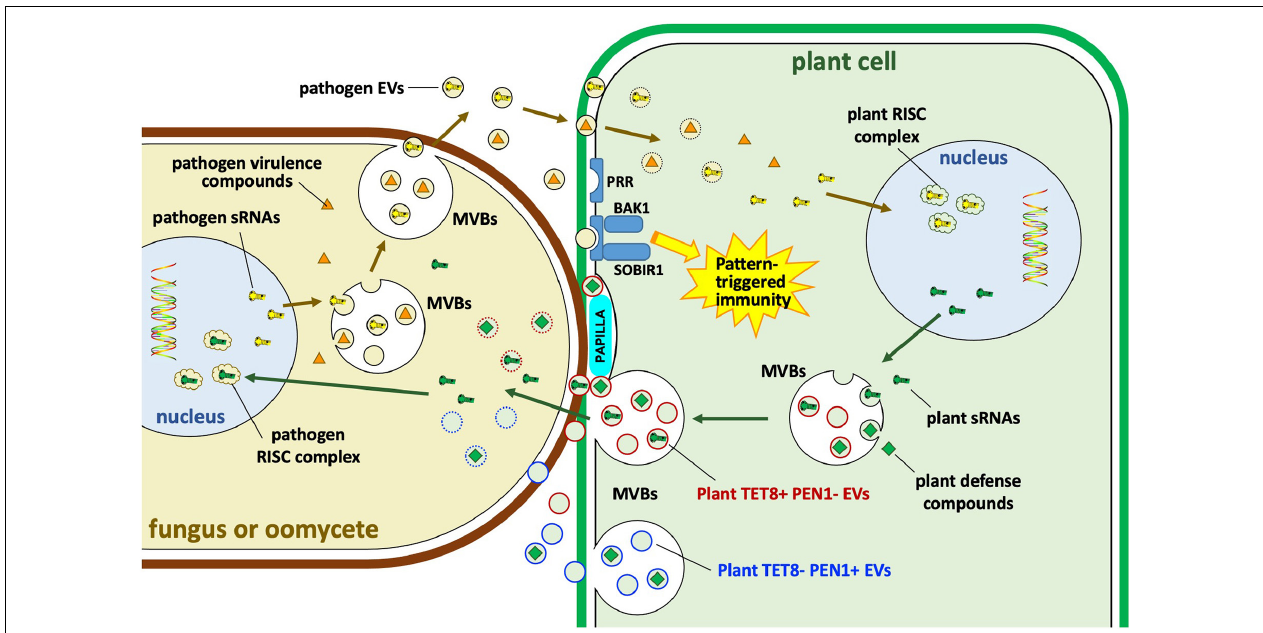
FIGURE 6 | Extracellular vesicle roles in interactions of plants with fungi and oomycetes. Plants and their eukaryotic pathogens exchange EVs during infection. Plant EVs carrying Tetraspanin8 (Tet8) but lacking syntaxin PEN1 (TET8+ PEN1– EVs) carry small RNAs (sRNAs) and other defense compounds including small molecules, enzymes and other proteins. The specific role of plant TET8-negative PEN1-positive (TET– PEN1+) EVs remains unclear. Some of those molecules may enter the pathogen cytoplasm or the nucleus where sRNAs may bind to pathogen RNA-induced silencing complexes (RISC); some enzymes such as callose synthase may be targeted to papillae to strengthen cell wall defenses against pathogen invasion. Pathogen EVs may carry sRNAs as well as other virulence compounds, possibly including some effectors. sRNAs may target plant RISC complexes. MVBs, multivesicular bodies; PRR, pattern recognition receptor; BAK1, BRASSINOSTEROID INSENSITIVE 1-associated receptor kinase 1; SOBIR1, suppressor of BRASSINOSTEROID INSENSITIVE 1 (BRI1)-associated kinase (BAK1)-interacting receptor kinase 1.